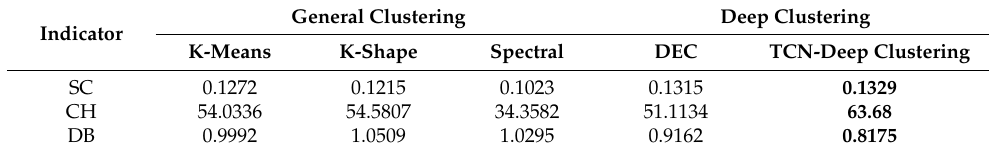
Table 4. CSI 300 Index clustering